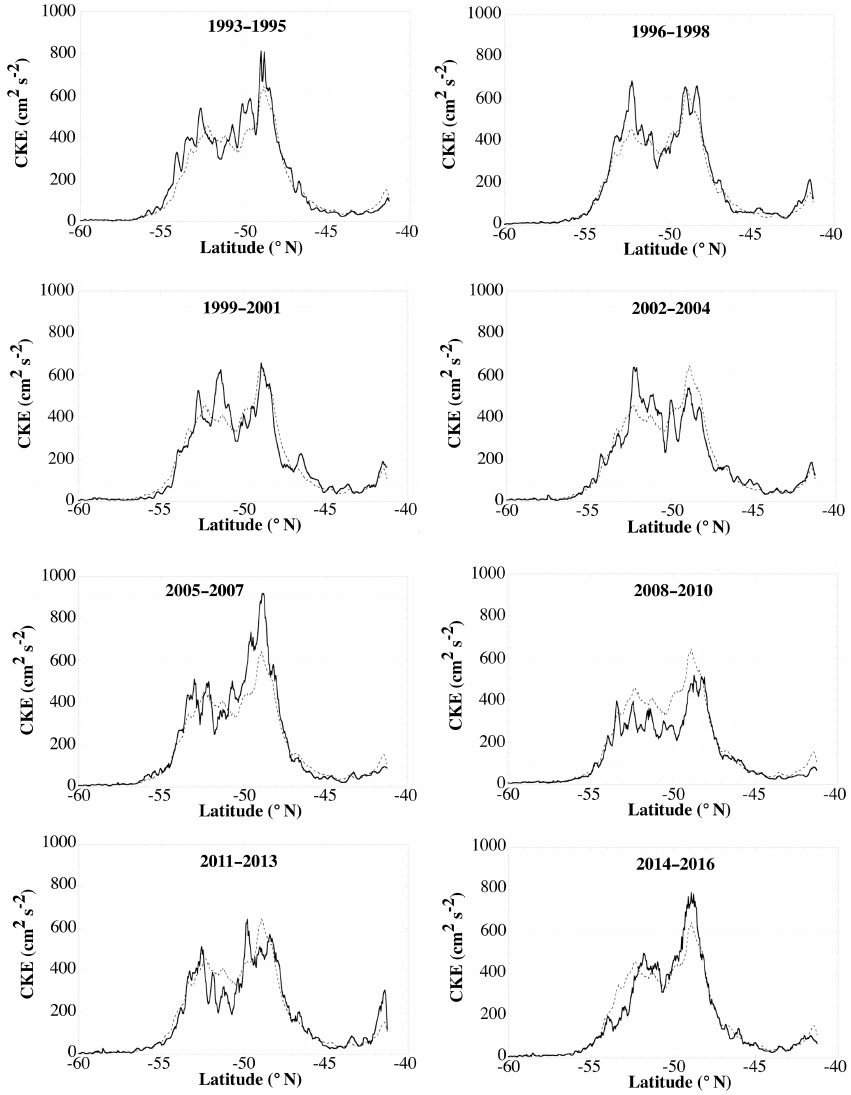
Figure 4. Three-year averages of CKE estimated along pass shown in Fig. 2 (solid lines) along with the long-term mean from 1993 to 2016 (dotted